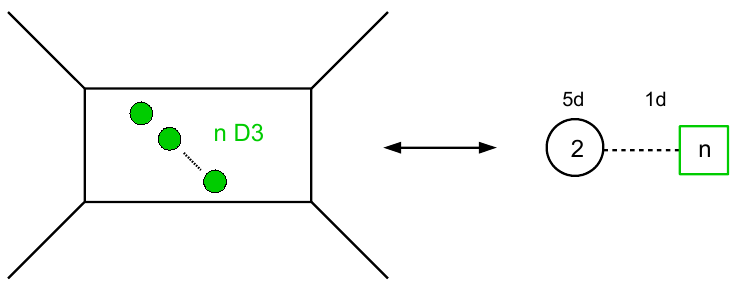
Figure 5 . Adding n D3 branes realizes a quiver theory with a Fermi multiplet in the bifundamental of the SU(2) (cid:2) U( n ) f (cid:13)avor